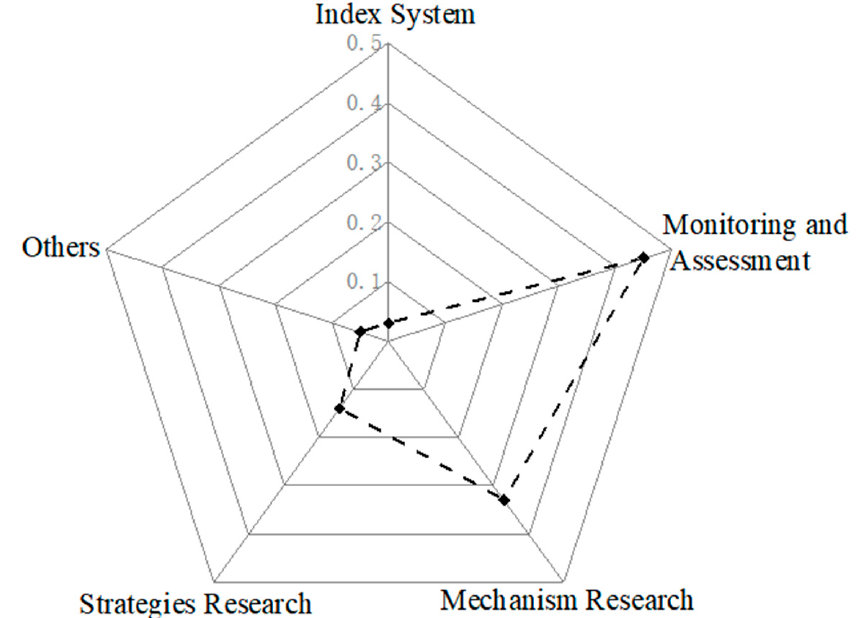
Figure 2. Literature by content.